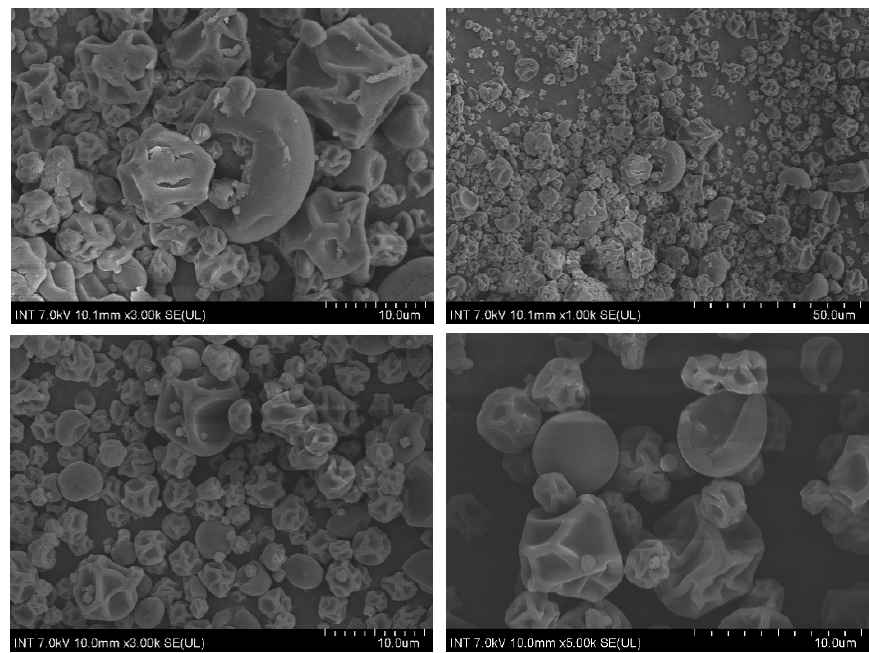
Figure 5. Scanning electron micrographs of the particles containing lemongrass essential oil using maltodextrin as wall material.